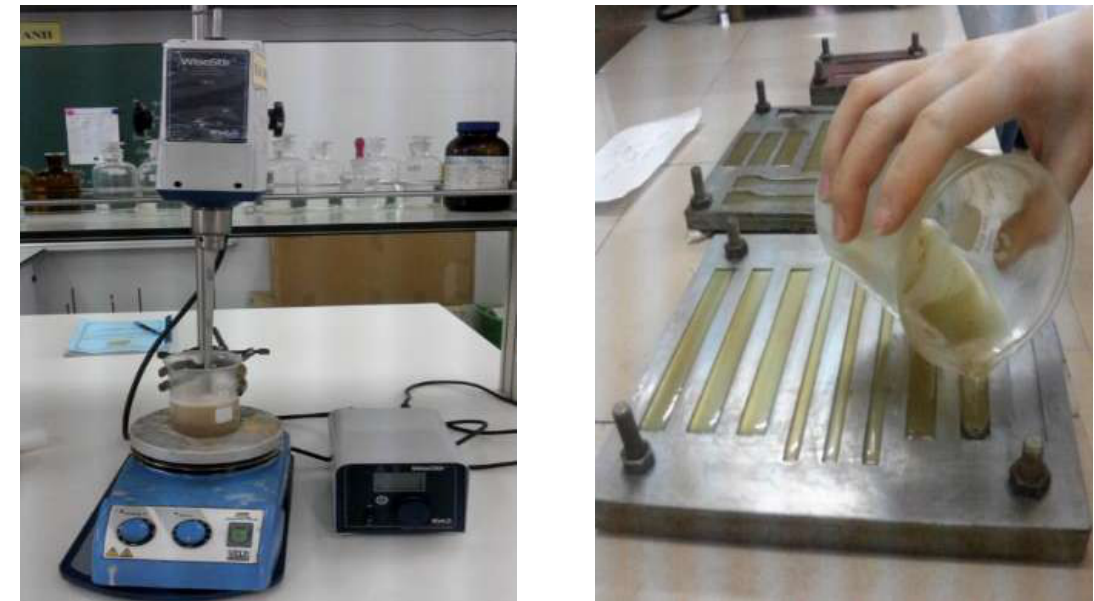
FIG. 5. MANUFACTURING SET UP OF EPOXY COMPOSITE: EPOXY EPIKOTE 240/ELO/ SB